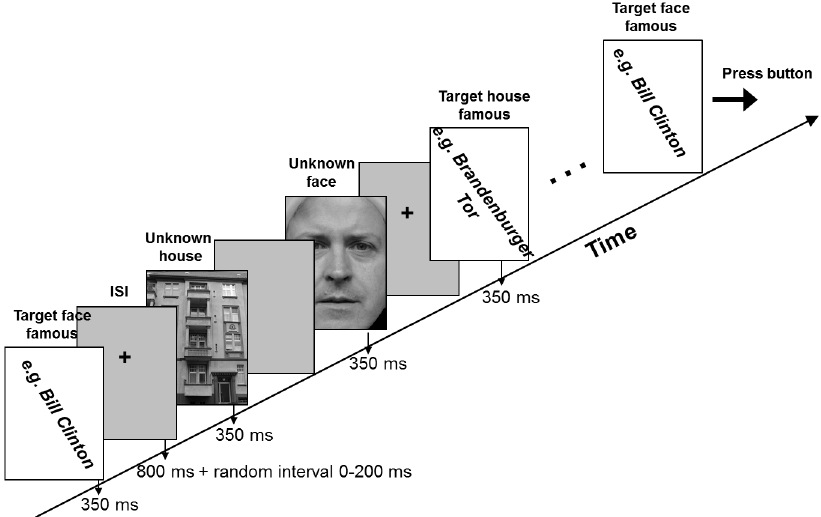
Fig 2. Stimuli and task for experiment 2. In contrast to experiment1 persons now had to respond to a single famous face or house which was inserted in the random sequence of unknown faces and houses. Because of copyright issues no examples of famous faces (e.g. Bill Clinton) and houses (e.g. Brandenburger Tor) are